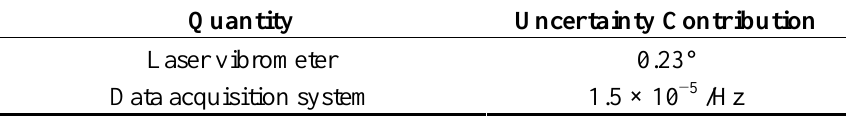
Table 2. Type B uncertainty contributions for the sensitivity